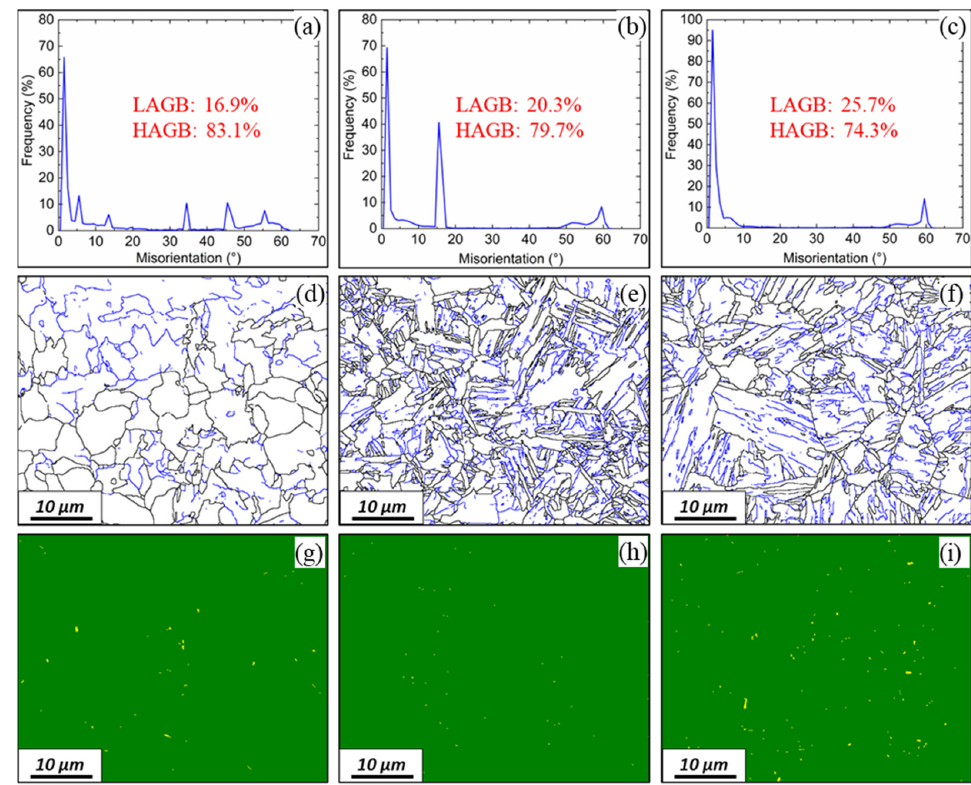
Figure 9. HAGB and LAGB fraction comparison, grain boundary misorientation distribution, and FCC and BCC distribution of ( a , d , g ) the as-received specimen, ( b , e , h ) specimen No. 2, and ( c , f , i ) specimen No. 6.